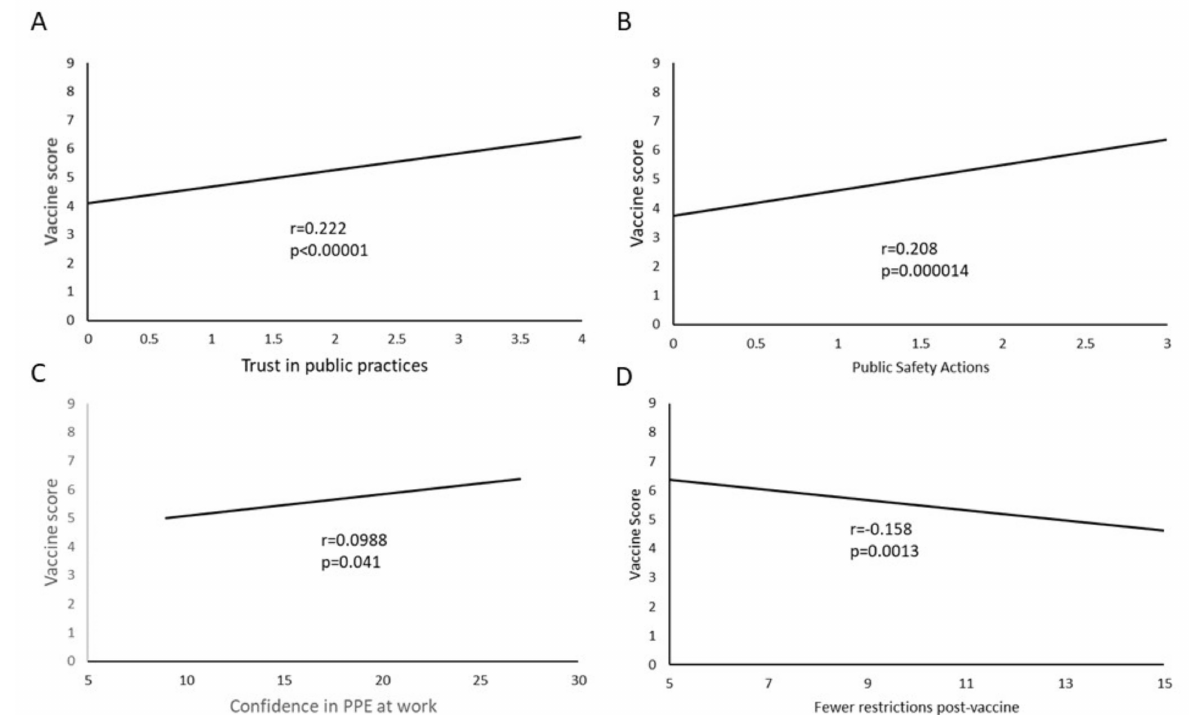
Figure 3. Personal Protective equipment (PPE) practices correlate with vaccine attitudes. ( A ) Participants with high trust in PPE and behavioral actions in public also have more intention to be vaccinated as measured by the COVID-19 vaccine attitude score. ( B ) Participants who use masks and behavioral modifications in public also have higher intention to be vaccinated. ( C ) Confidence in PPE and behavioral modification to keep the participants and colleagues safe from infection in the hospital is mildly correlated with increased intent to vaccinate. ( D ) Intent to vaccinate is correlated with the expectation that protective equipment and practices will need to be continued even after vaccination. Sample size for each was N = 428. Only trendlines are shown for each of the dot plots to decrease